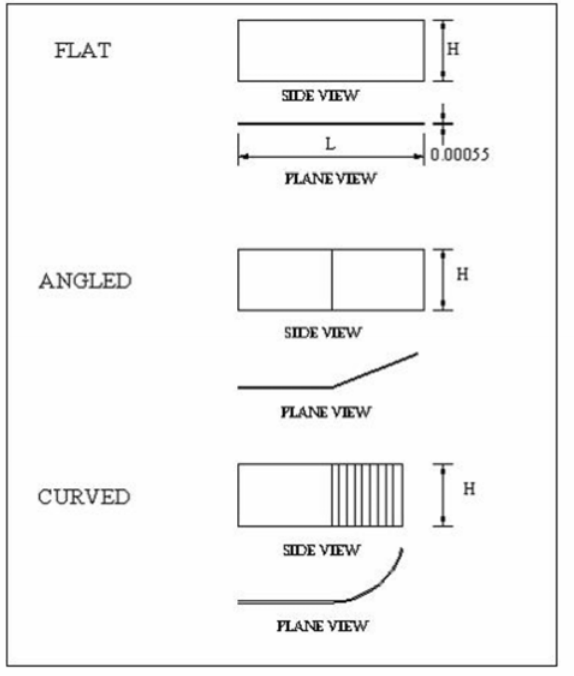
Fig. 3. Detail of vanes’